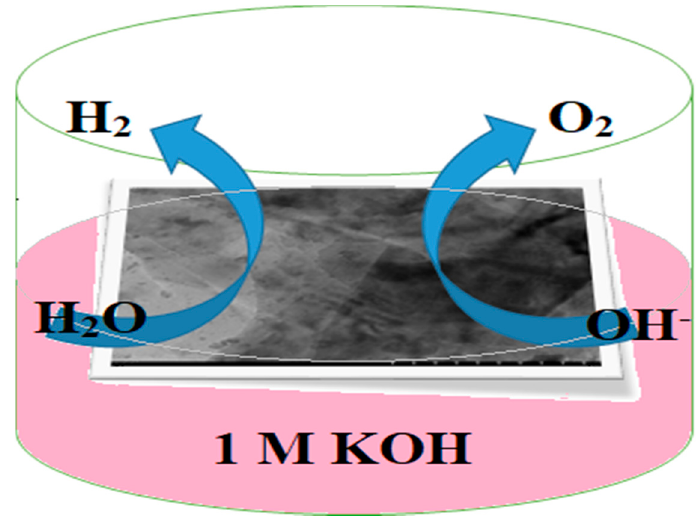
Figure 8. Activity diagram of Cu 2 O-Co 3 O 4 /CN composite.